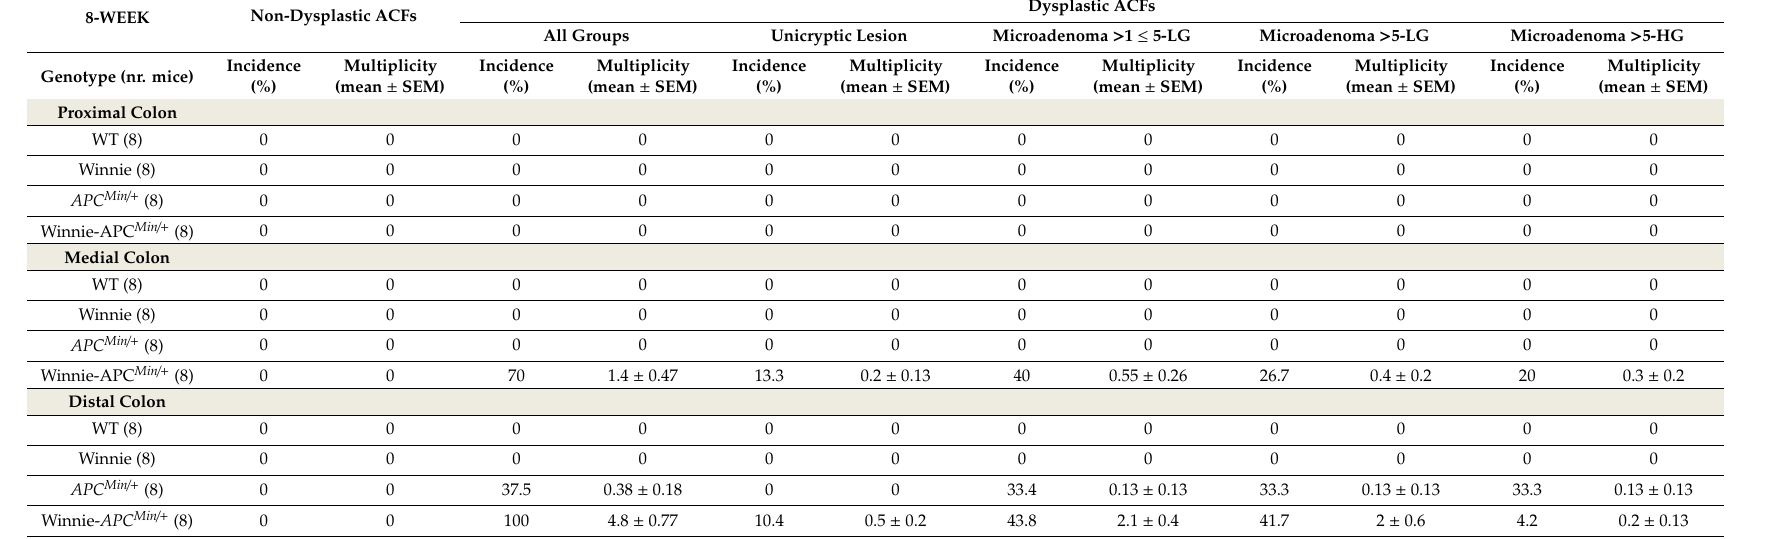
Table 2. Histological analysis of 8-week-old Winnie- APC Min /+ mice and control littermates. The incidence and multiplicity ± SEM of proximal, medial and distal colon were calculated for non-dysplastic and dysplastic ACFs. The score for dysplastic ACFs was calculated relative to all groups and to each group of neoplastic lesions classified according to dimension and grading of unicryptic lesions; microadenoma > 1 ≤ 5 crypts low-grade (LG); microadenoma > 5 crypts low-grade (LG) and microadenoma > 5 crypts high grade